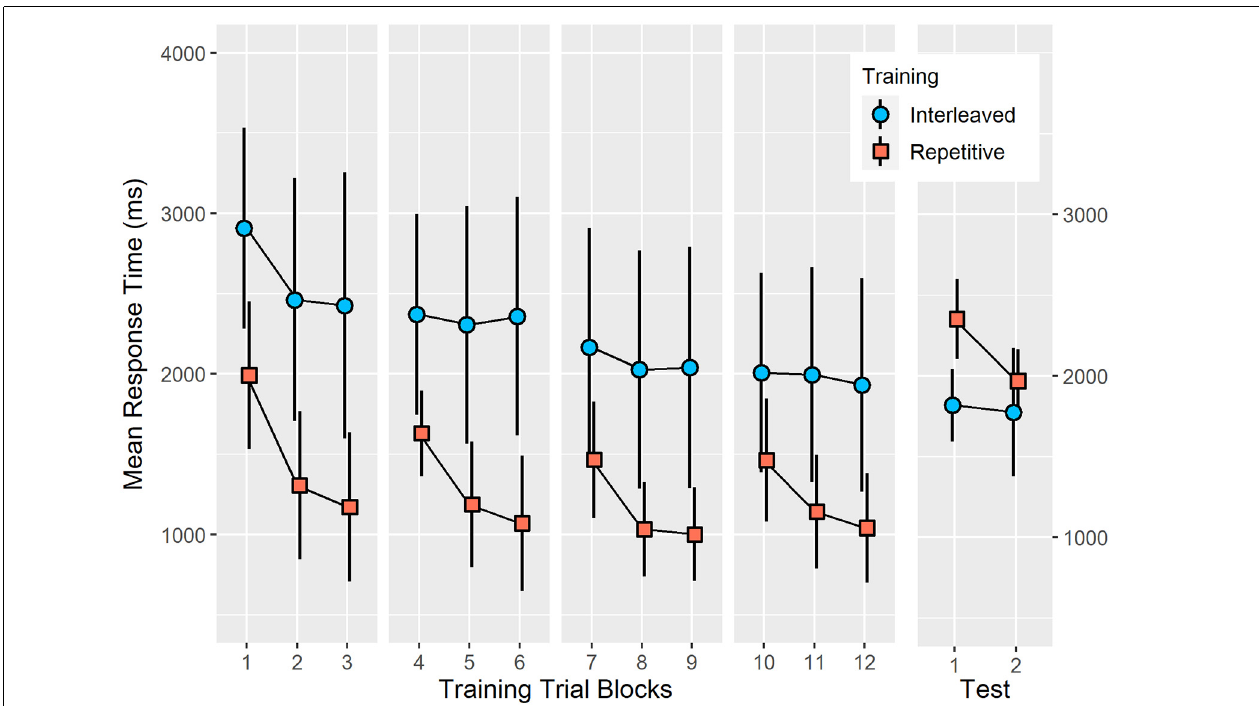
FIGURE 2 | Mean response time of accurate bimanual five-key press sequences during training under interleaved or RP schedules and a 24-h delayed test. The pattern of results was consistent with the contextual interference effect (Shea and Morgan, 1979) since IP resulted in a significantly longer mean response time at training ( p < 0.001, η 2 p = 0.53) but resulted in a significantly shorter mean response time at test ( p < 0.001, η 2 p = 0.35). Error bars represent standard deviation.